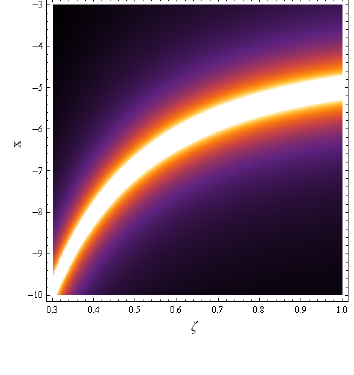
Figure 1. Variation of solution (9) versus x and ς